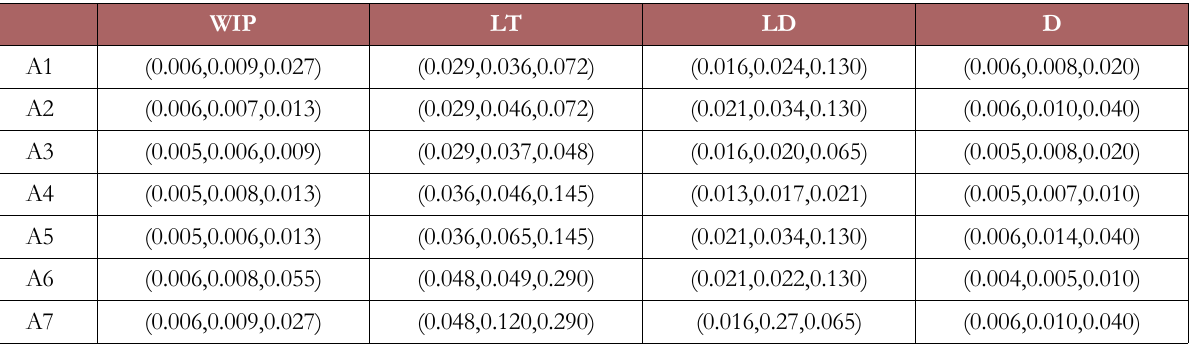
Table 11. Weighted normalized fuzzy decision matrix for solution